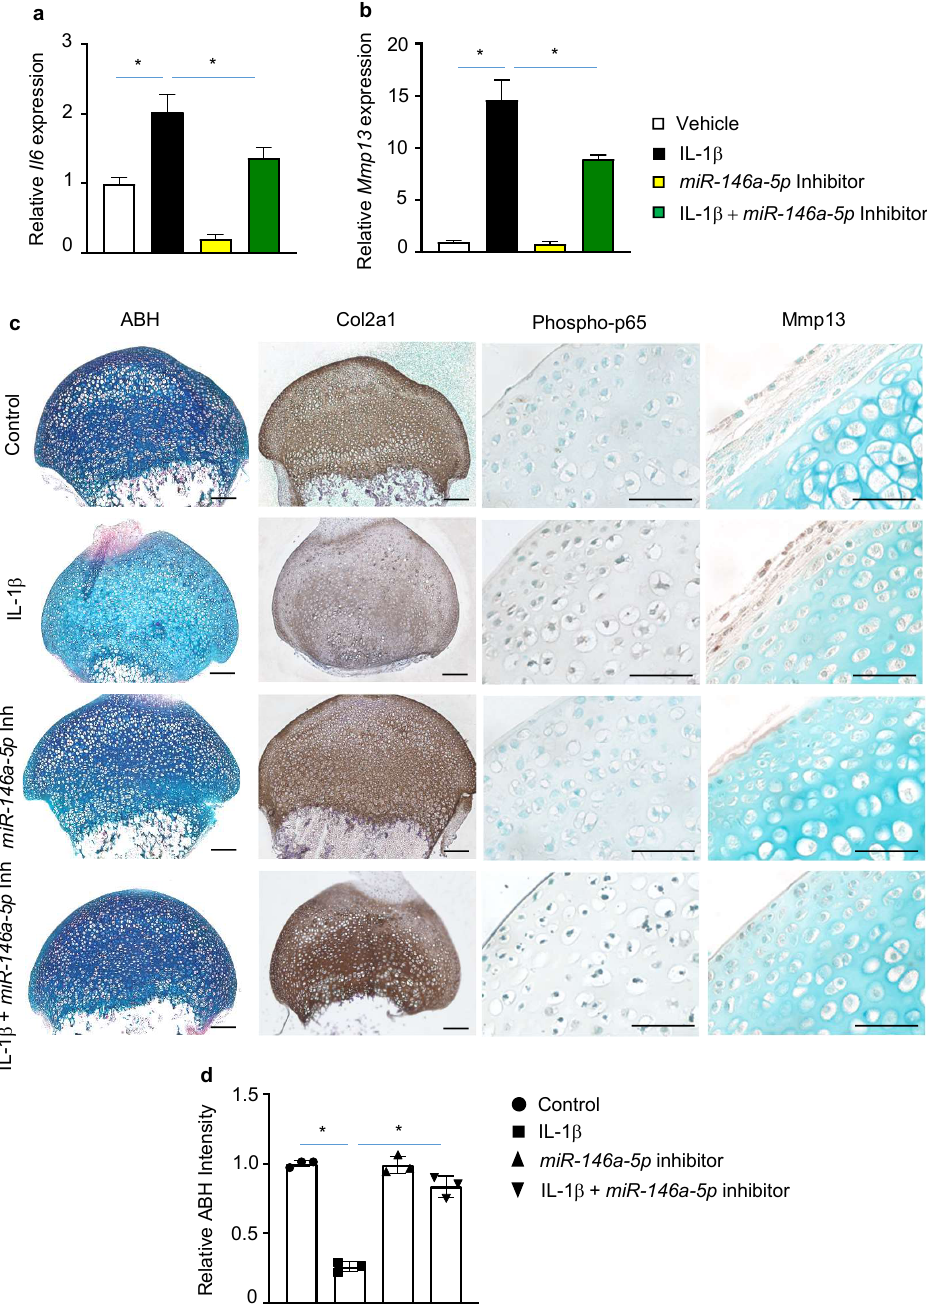
Figure 3. Suppression of miRNA-146a-5p antagonizes IL-1 β -induced inflammation and catabolism articular chondrocytes. Relative gene expression analyses for ( a ) Il6 and ( b ) Mmp13 in IL-1 β -